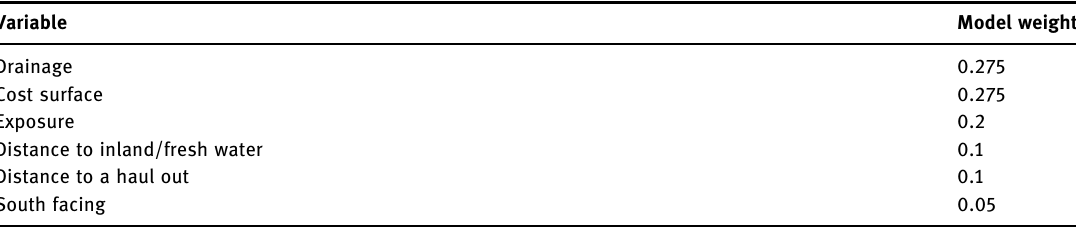
Table 3: Weights assigned to each variable in the predictive